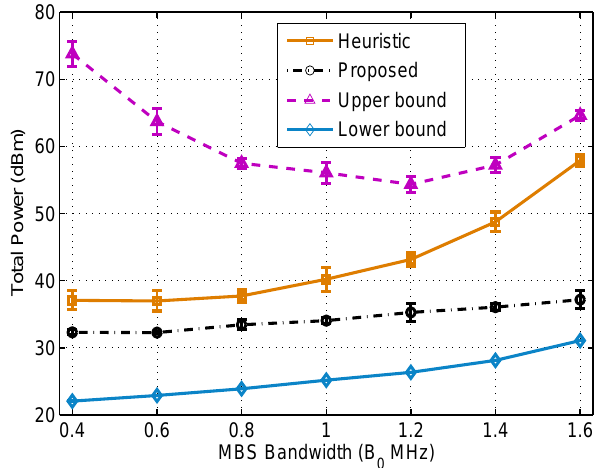
Figure 7. Total power vs. bandwidth of